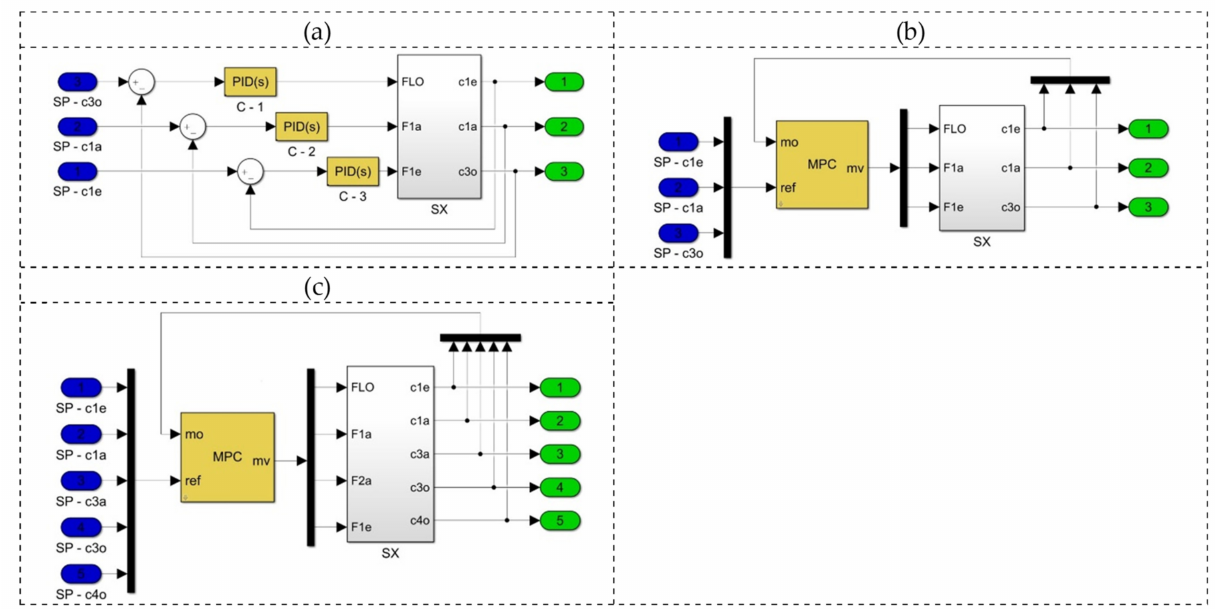
Figure 11. Control systems for SX plant: ( a ) 3 × 3 PID, ( b ) 3 × 3 MPC, ( c ) 4 × 5